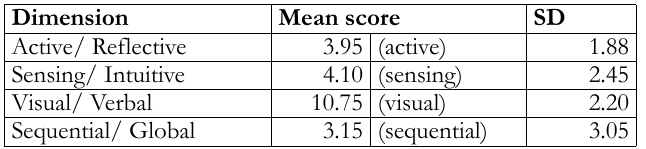
Table 3. Mean learning style preferences (n=67)